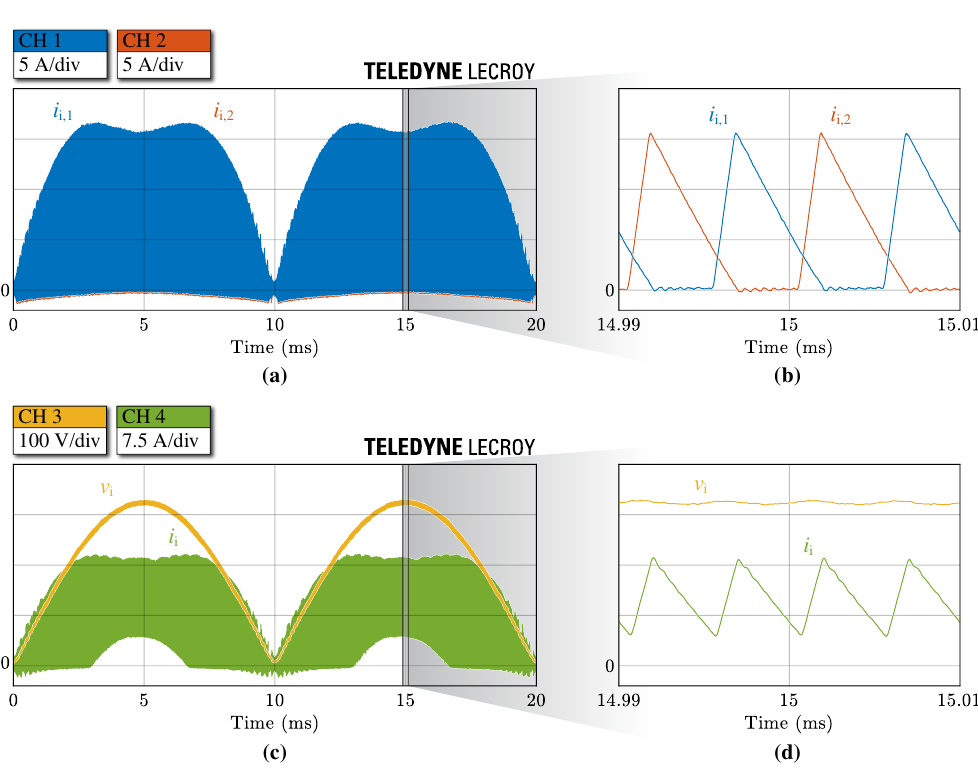
Figure 16. Experimental waveforms of ( a , b ) the inductor currents ( i i,1 and i i,2 ) and ( c , d ) the input capacitor voltage ( v i ) and the input current ( i i ) for 50% load ( P = 1650W).